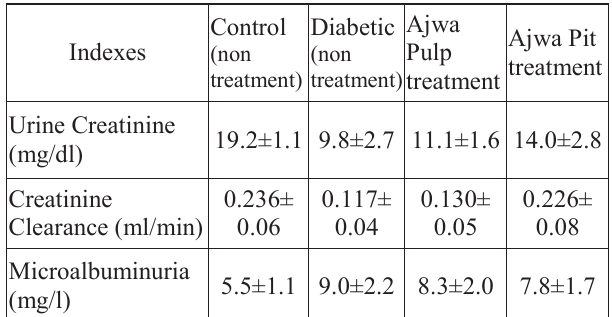
Table-2: Results for urine creatinine, creatinine clearance and microalbuminuria at 4